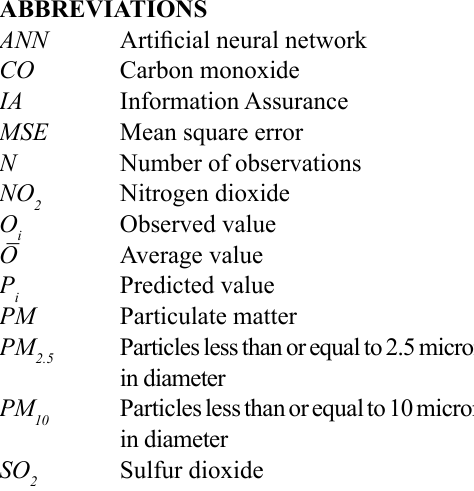
Fig. 6: "R" values for training, validation, test, and all data for regression